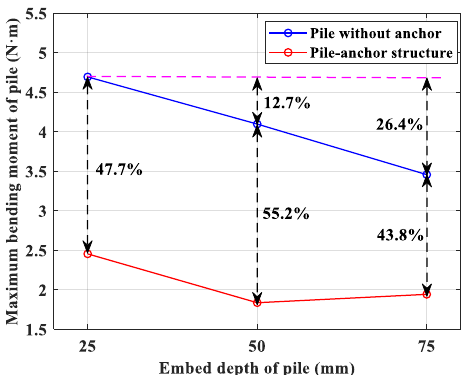
Figure 11. Maximum bending moment of the pile. (The double arrow lines denote the percentage of decrease). Materials 2020 , 10 , x FOR PEER REVIEW